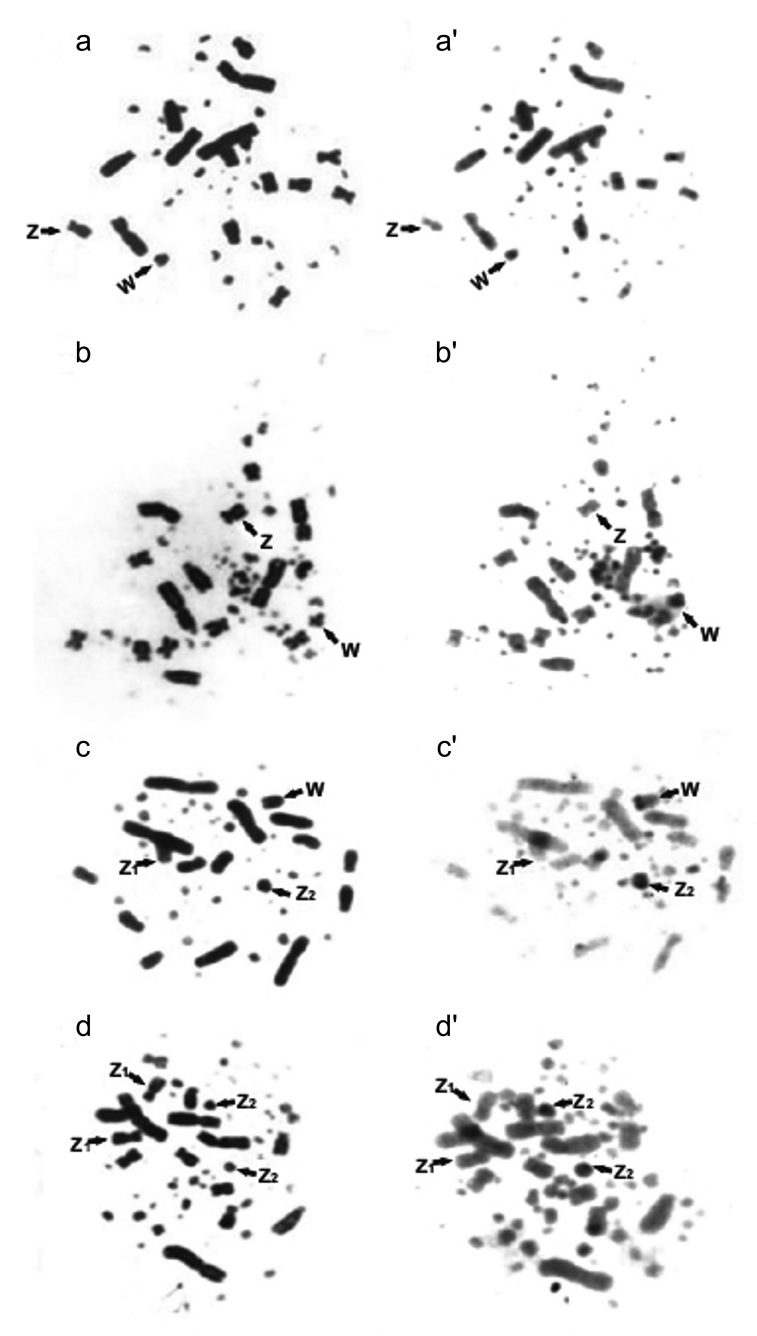
Figure 2. Metaphases in sequential Giemsa-C banding analysis a-a’ female of the P. antarcticus b-b ' female of the P. papua, c-c ' female and d-d ' male of P. adeliae . The arrows show the sex chromosomes Z, Z and 2